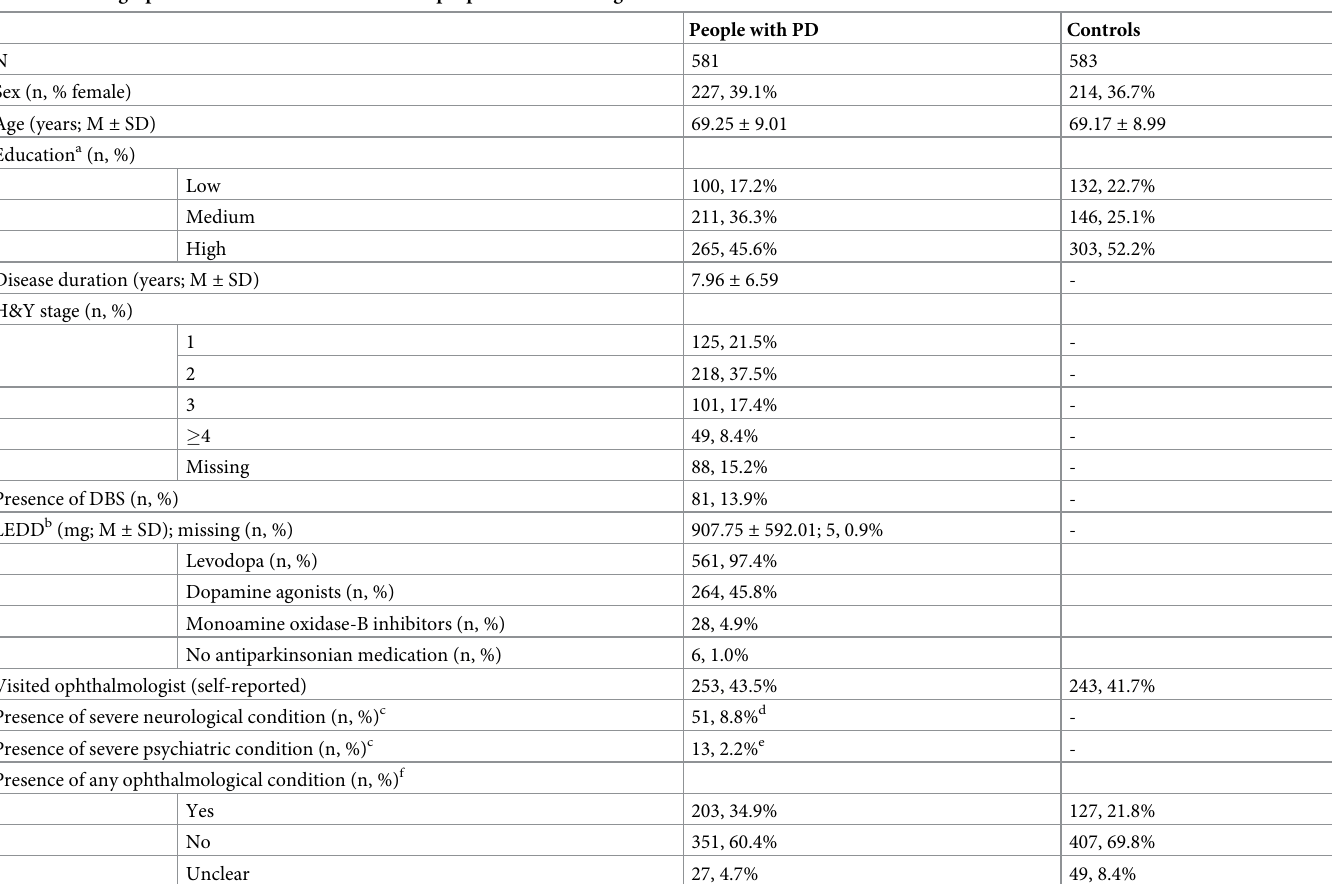
Table 1. Demographics and disease characteristics of people with PD and age-matched